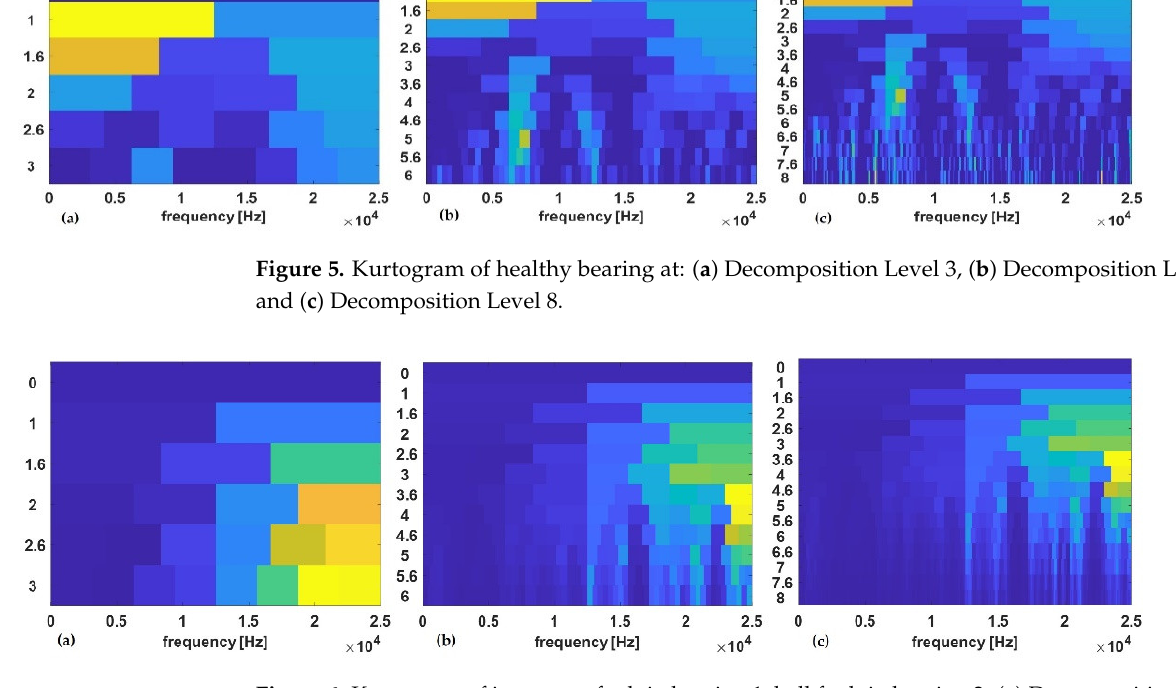
Figure 6. Kurtogram of inner race fault in bearing 1, ball fault in bearing 2: ( a ) Decomposition Level 3, ( b ) Decomposition Level 6, and ( c ) Decomposition Level 8.